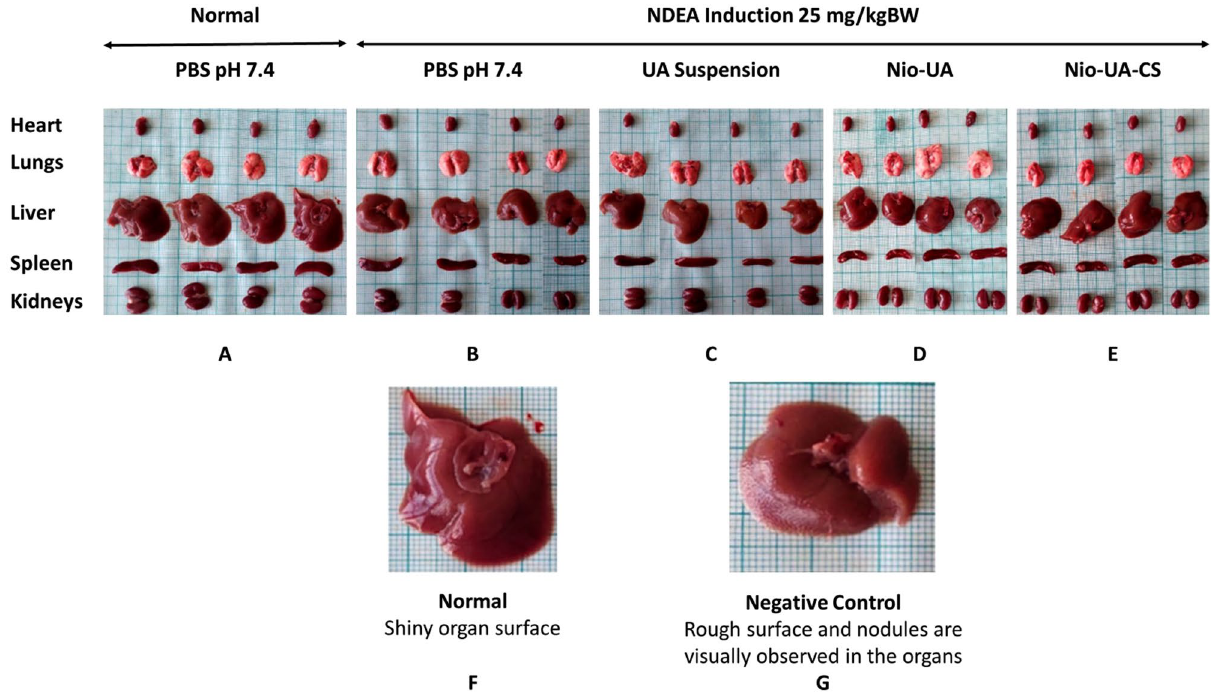
Figure 3. Morphology of the heart, lungs, liver, spleen, and kidneys in group ( A ) of normal subjects with PBS pH 7.4 and oral administration; ( B ) intraperitoneal-induced negative control 25 mg NDEA/kgBW with PBS pH 7.4; induced ip 25 mg NDEA /kgBW with ( C ) UA suspension ( D ) Nio-UA ( E ) Nio-UA-CS which is equivalent to 11 mg UA/kgBW. Differences in liver morphology in the ( F ) normal and ( G ) negative control groups induced by NDEA at a dose of 25